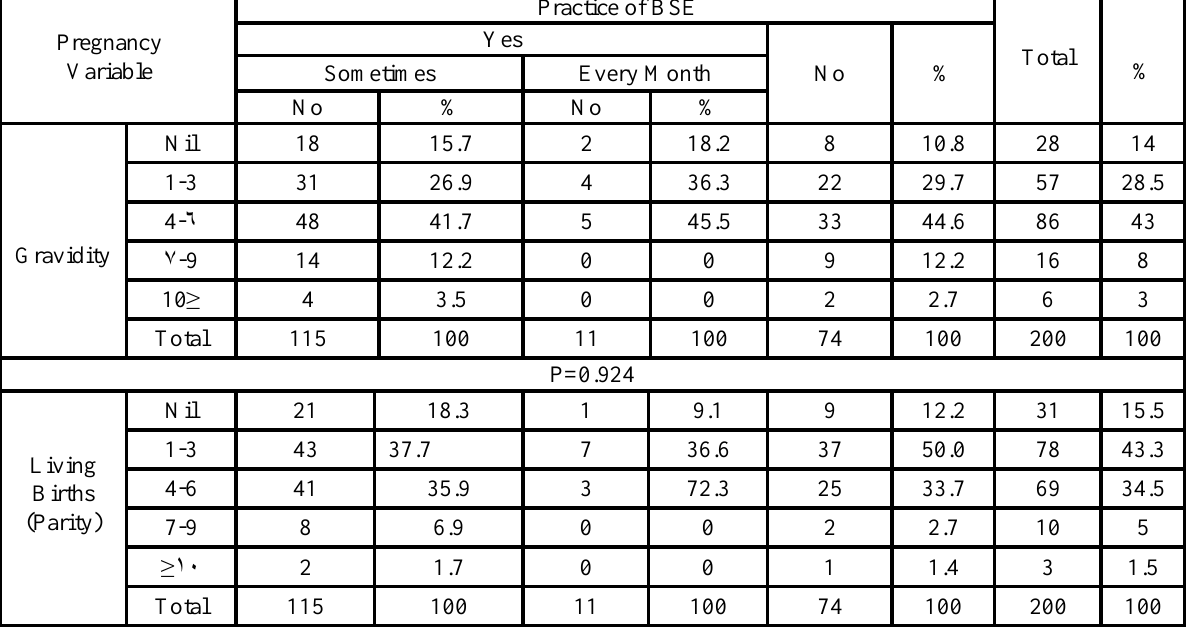
Table (3): Correlation of the frequencies of gravidity, parity and abortions with BSE